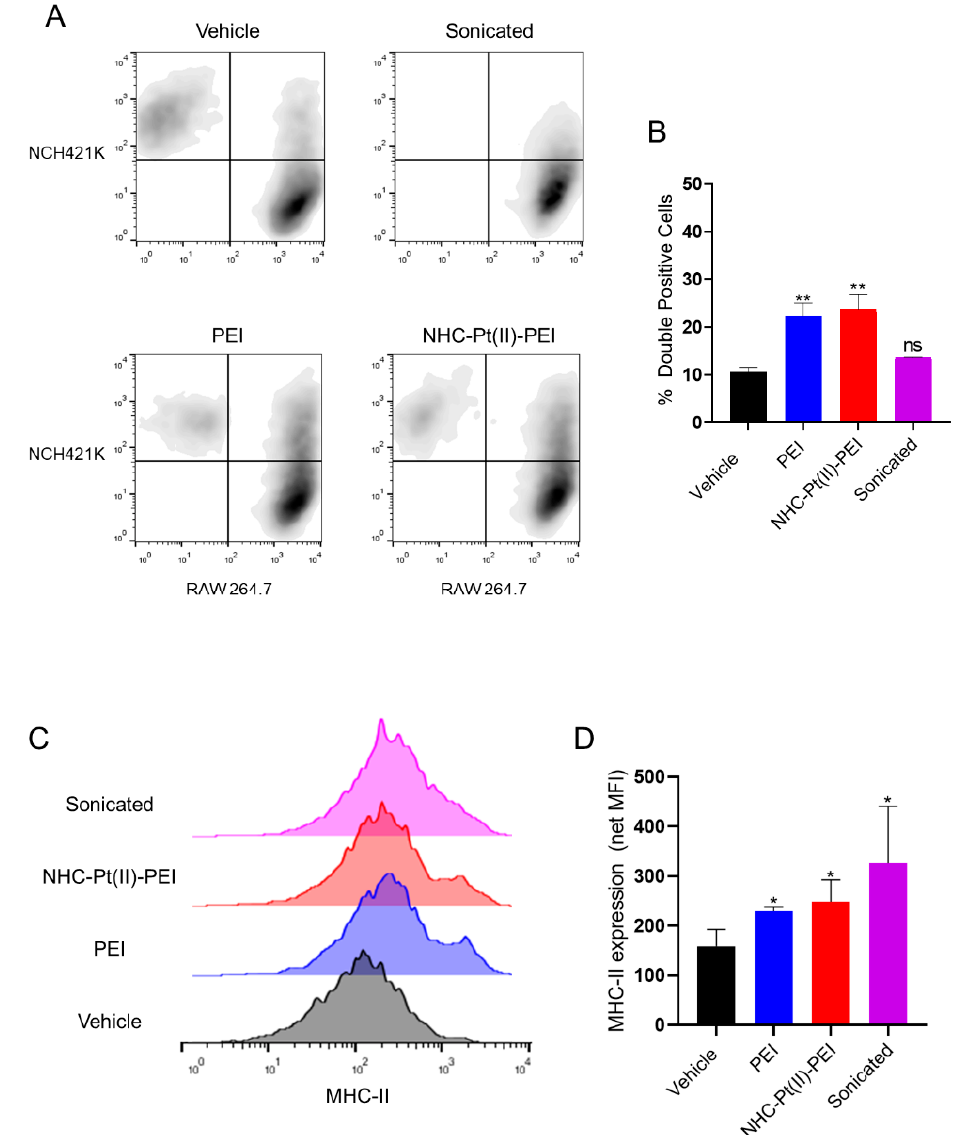
Figure 11. Phagocytosis and macrophage activation by 6 h 5 µ M NHC-Pt(II)-PEI and 5 µ M PEI eq treated NCH421K spheroid co-culture. ( A ) Representative flow cytometry dot plots (FlowJo v10) of stained NCH421K spheroids treated for 6 h prior to addition of stained RAW macrophages for overnight co-culturing. ( B ) Histograms showing the percentage of double-positive (RAW phagocy- tosed NCH421K) cells representing the mean of n = 3 independent experiments ± one SEM. Statistics represent Student’s t-tests vs. the corresponding vehicle reference. Distribution normality was confirmed using a Shapiro–Wilk test. ns = p > 0.05, ** = p ≤ 0.01. ( C ) Representative flow cytometry histograms (FlowJo v10) of MHC-II fluorescence. ( D ) Histograms showing net MFI (median) (MFI treatment—MFI isotype control) of treated cells. Values represent the mean of n = 3 independent ex- periments. Statistics represent Student’s t -tests vs. the corresponding vehicle reference. Distribution normality was confirmed using a Shapiro–Wilk test. * = p ≤